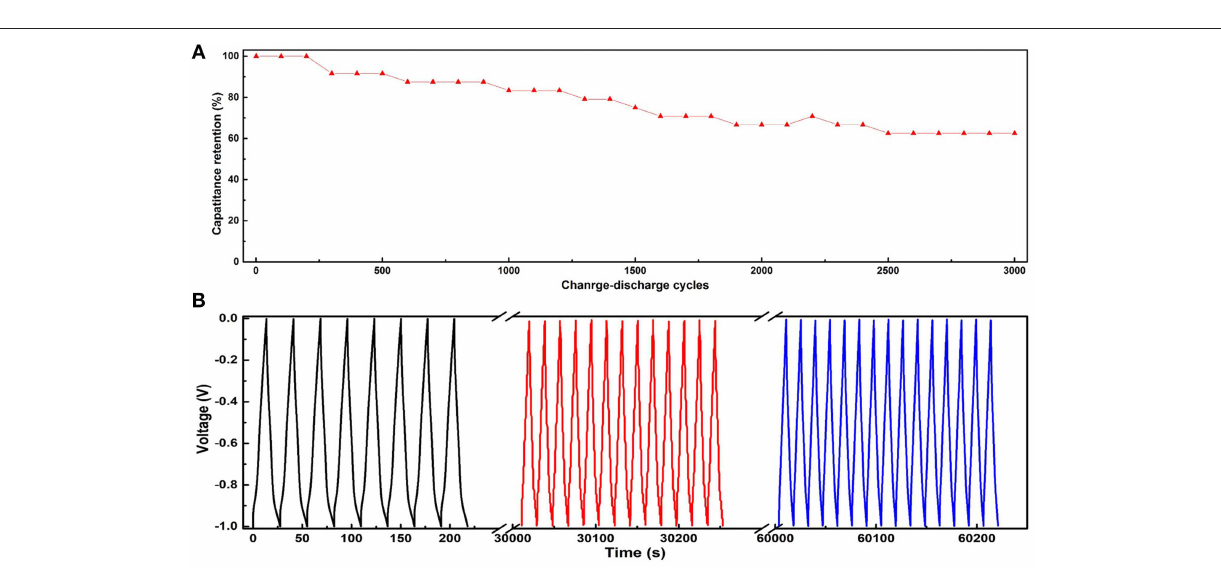
FIGURE 4 | (A) COP BTC -Mn/CF-1 capacitance retention after 3,000 charge–discharge cycles at the high current density of 10 A/g. (B) The charge–discharge profiles of COP BTC -Mn/CF-1 during a test of 3,000